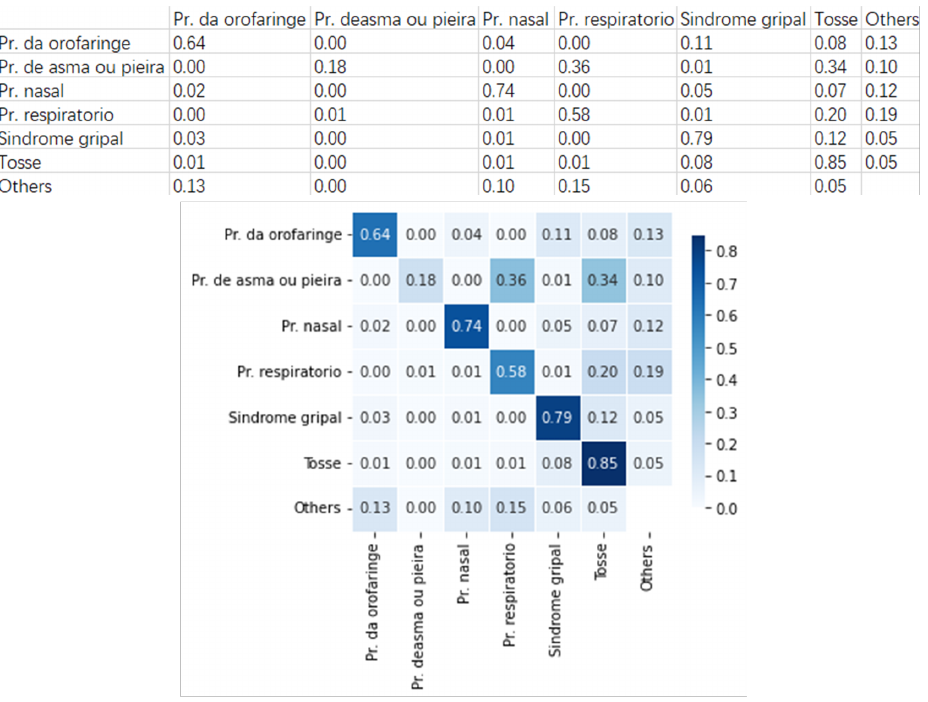
Figure 9. Analysis among clinical pathways with similar clinical symptoms using the trained neural network model. This group includes six clinical pathways: Pr. da orofaringe ( Oropharynx problem ), Pr. deasma ou pieira ( Asthma or wheezing problem ), Pr. nasal ( Nasal problem ), Pr. respiratorio ( Respiratory problem ), Sindrome gripal ( Flu syndrome ), Tosse ( Cough